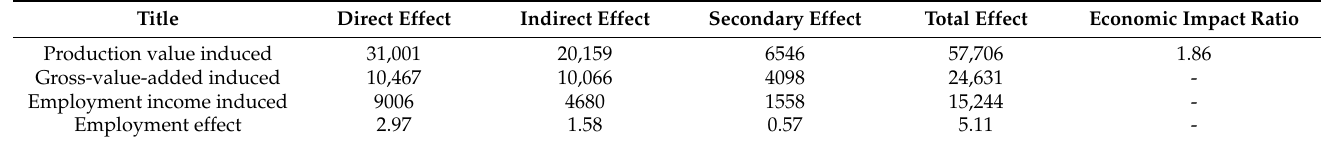
Table 4. The economic impact (measured in thousands of yen or in people) of the construction of a timber dam.